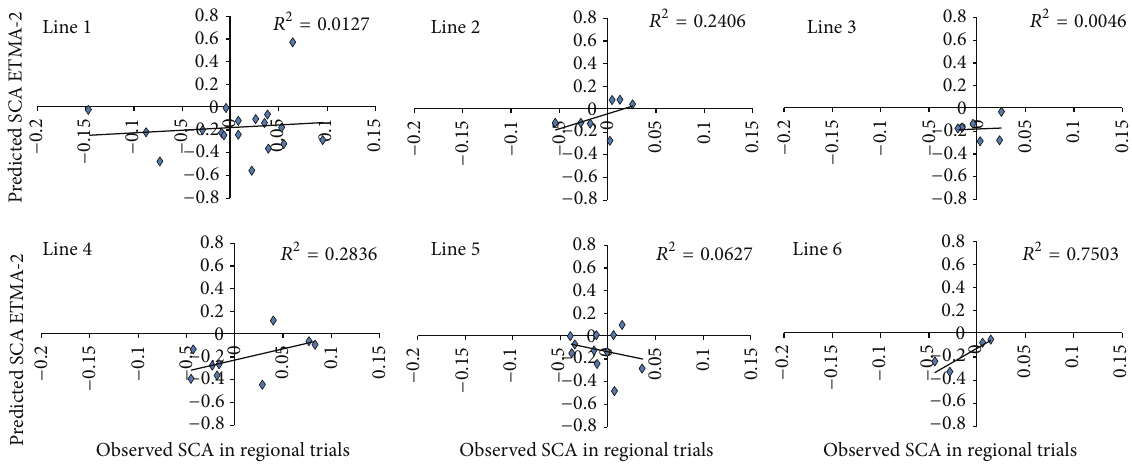
Figure 4: Total effects of associated markers (TEAM2) method fit per line with more than 4 crossing replicates (lines of 1–5).